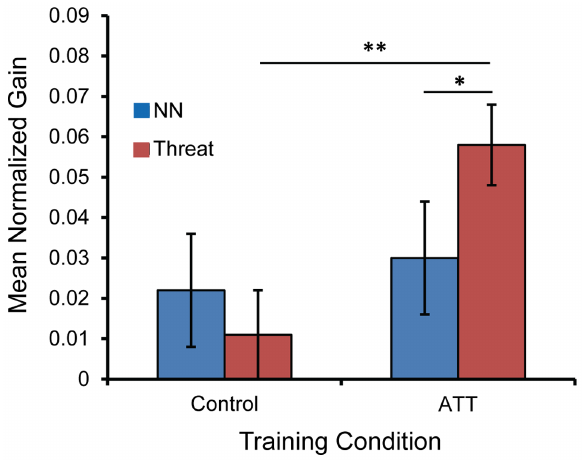
Figure 4. Selective effect of training condition on delayed (offline, between-session) gains. Mean delayed performance gains in Session 2, normalized to performance in the final block of Session 1, by Trial Type (NN, Threat) and Training Condition (ATT, Control). NN=neutral-neutral; ATT=attend-threat training. Error bars signify 6 1 s.e.m. * p , 0.05, ** p , 0.01.